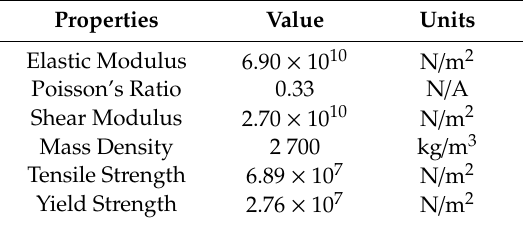
Table 2. Characteristics of 1060 Aluminum alloy.